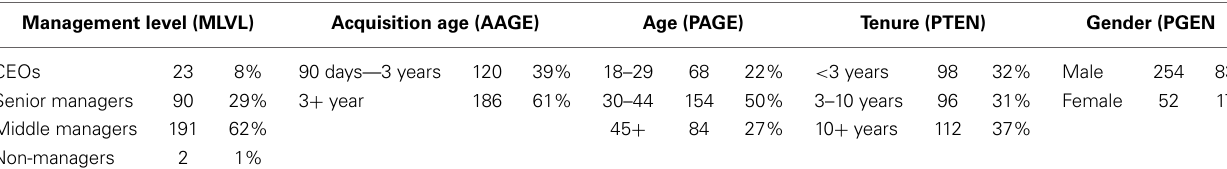
Table 2 | Description of